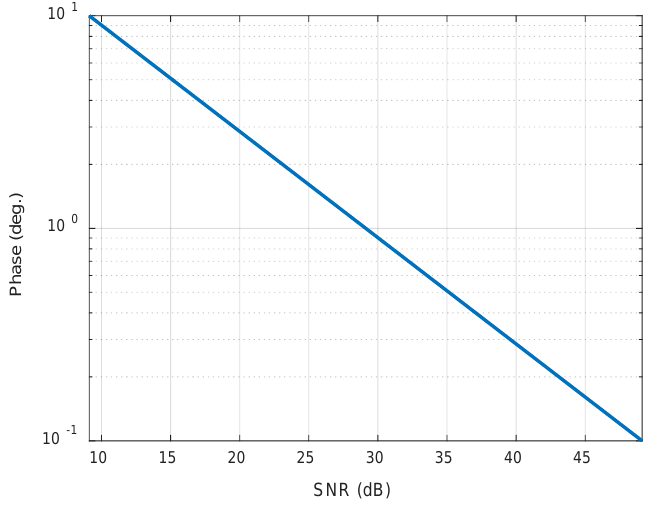
Figure 7. The standard deviation (STD) of phase errors versus signal-noise ratio (SNR).